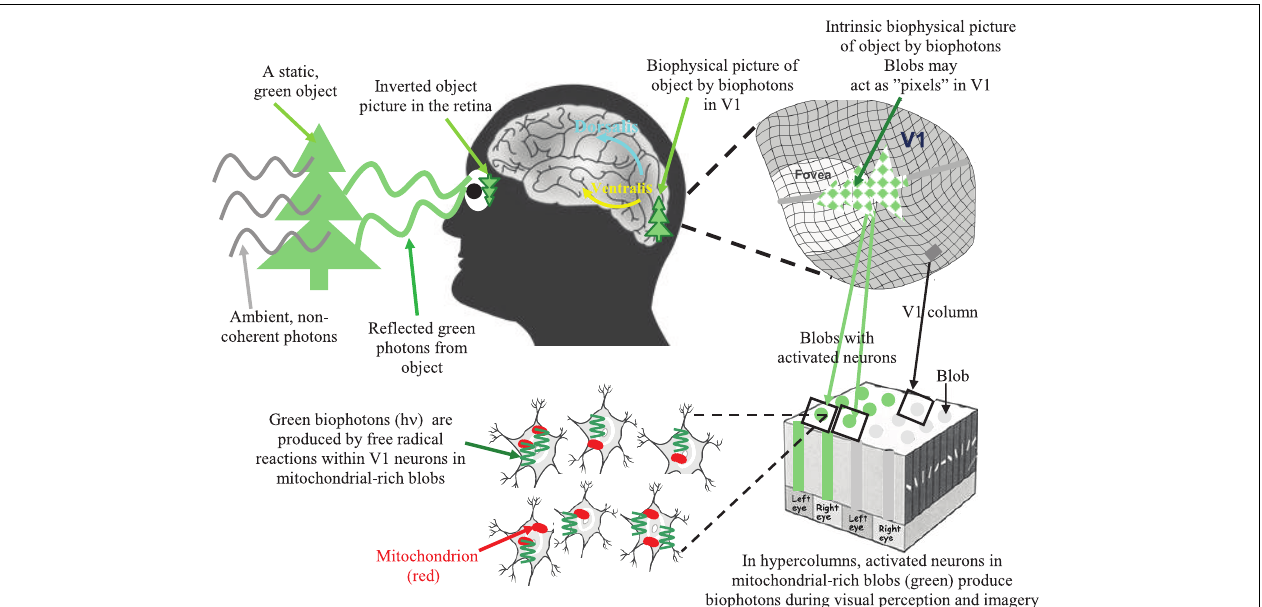
FIGURE 1 | A simple illustration of the biophysical picture representation idea (also called intrinsic biophysical virtual visual reality) during visual perception and imagery (Bókkon, 2009; Bókkon and D’Angiulli, 2009). External photon signals reflected from an object are converted into retinotopic electrical signals inside the retina. Next, retinotopic electrical signals are conveyed to the V1 and transformed into controlled biophotons by mitochondrial redox processes within the V1 neurons. Specifically, spike-related, retinotopic electrical signals create synchronized biophotons along classical axonal-dendritic pathways through a redox reaction within retinotopic V1 neurons. Small groups of visual neurons can function as “visual pixels” that are appropriate to the topological distribution of the retina’s photonic signals. Thus, we can get an intrinsic computational biophysical picture of the object created by biophotons in the retinotopic V1. The long-term visual information is not stored as pictures but as epigenetic codes. We are able to identify objects since the same epigenetic processes are activated every time we see an object. Therefore, the representation